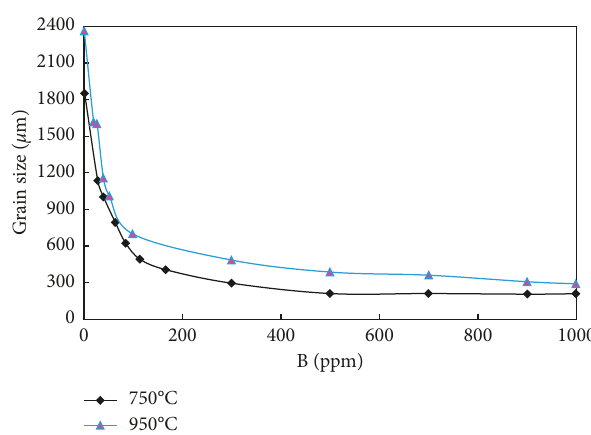
Figure 12: Variation of the grain size as a function of the added B and pouring